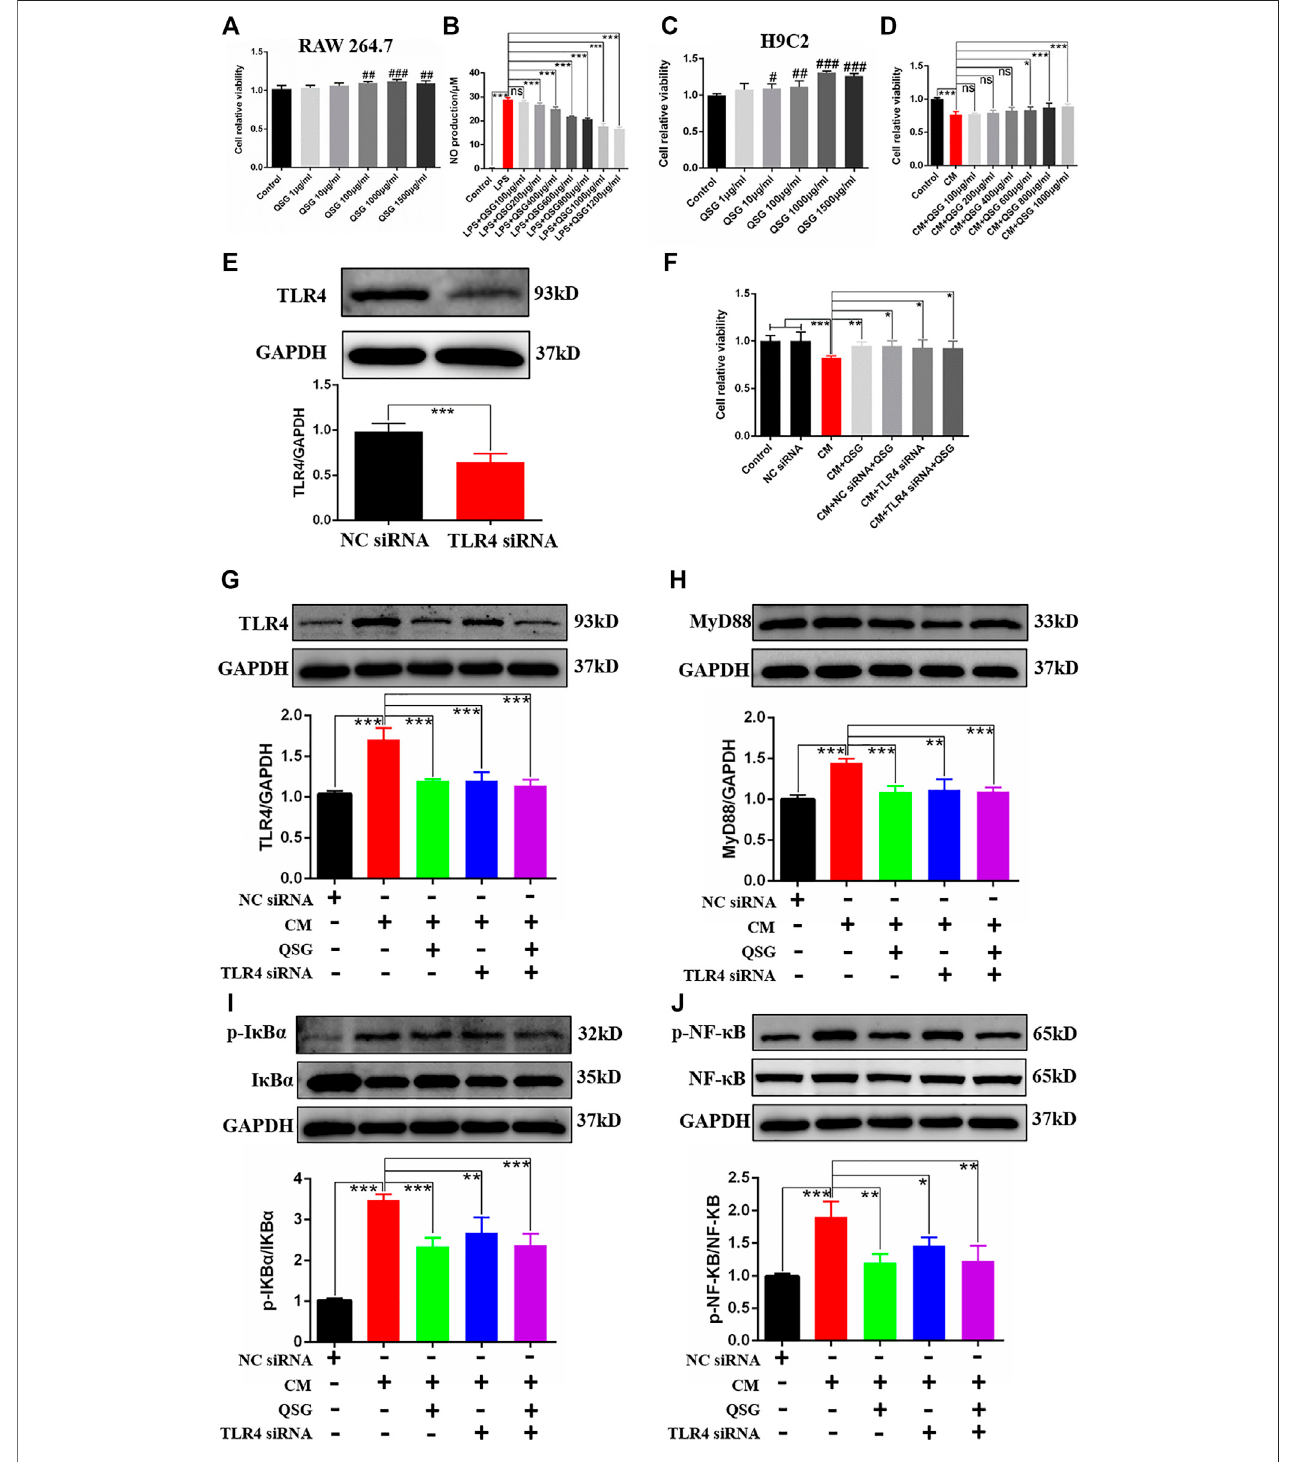
FIGURE 4 | QSG might attenuate in fl ammatory injury in cardiomyocytes by inhibiting the TLR4-MyD88-NF- κ B p65 pathway. (A) The CCK8 assay showed that QSG treatment for 24 h had no cytotoxic effect on RAW264.7 macrophages below 1,500 μ g/ml, N = 6 per group. (B) The level of NO in the supernatant of RAW264.7 macrophages wasevaluated by NOkit determination, N= 6per group. (C) The CCK8 assayshowed that QSGtreatment for 24 h had no cytotoxic effect on H9C2 cells below1,500 μ g/ml,N=6pergroup. (D) TheeffectiveconcentrationsofQSGinCM-stimulatedH9C2cellswereanalyzedbyCCK8assay,N=6pergroup. (E) The knockdown ef fi ciency of TLR4 siRNA in H9C2 cells was checked by western blot analysis, N = 3 per group. (F) TLR4 siRNA treatment increased the viability of CM- stimulated H9C2 cells. N = 6 per group. Representative western blot images and quanti fi cation of TLR4 (G) , MyD88 (H) , p-I κ B α and I κ B α (I) , p-NF- κ B p65 and NF- κ B p65 (J) in H9C2 cells from different groups, N = 3. GAPDH was used as a loading control. # p < 0.05, ## p < 0.01, ### p < 0.001 vs. control group. * p < 0.05, ** p < 0.01, *** p < 0.001 vs. model group. Frontiers in Pharmacology |